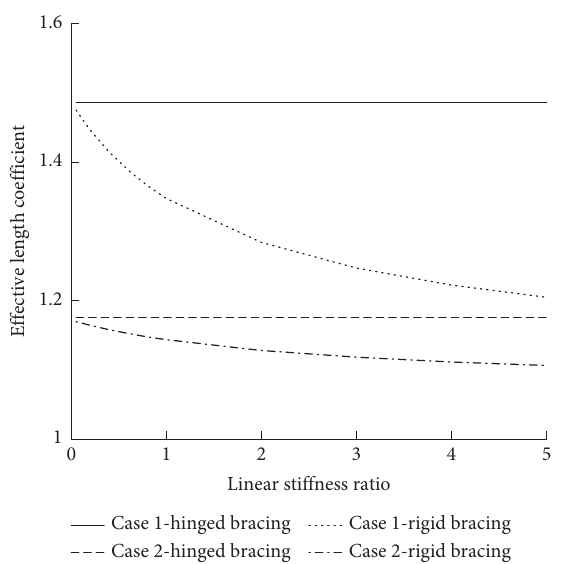
Figure 11: Effective length coefficient-linear stiffness ratio (K)